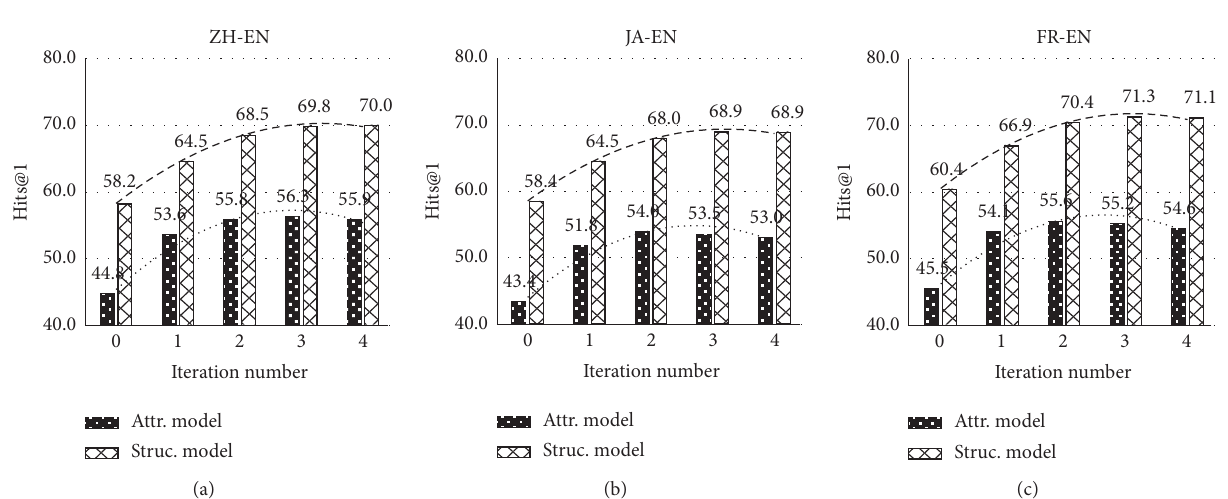
Figure 3: Hits @ 1 performances of the two-component models in each iteration. (a) DBP